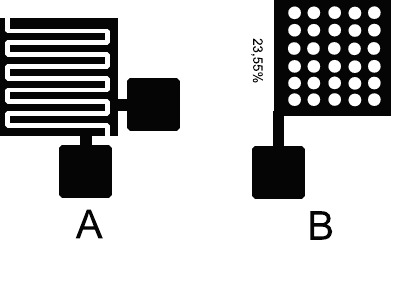
Figure 1. 2nd generation sensors ( A —lateral capacitor, B —perforated flat plate capacitor).